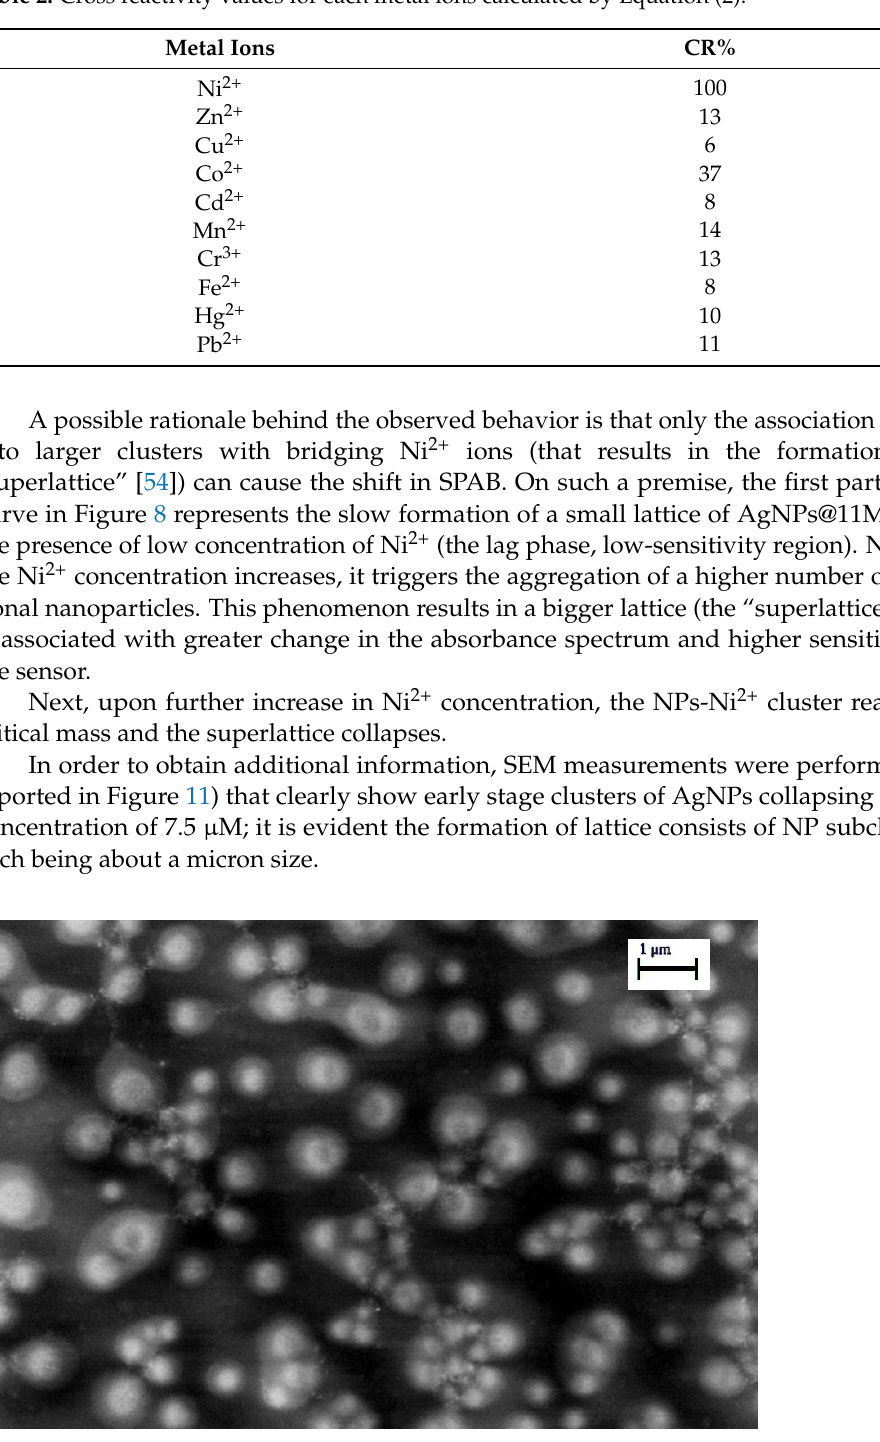
Figure 11. Morphology of AgNPs@11MUA after addition of 7.5 µM of Ni 2+ . Operative condition: 7.00 kV, WD = 1.4 mm and Mag = 19.17 kX.